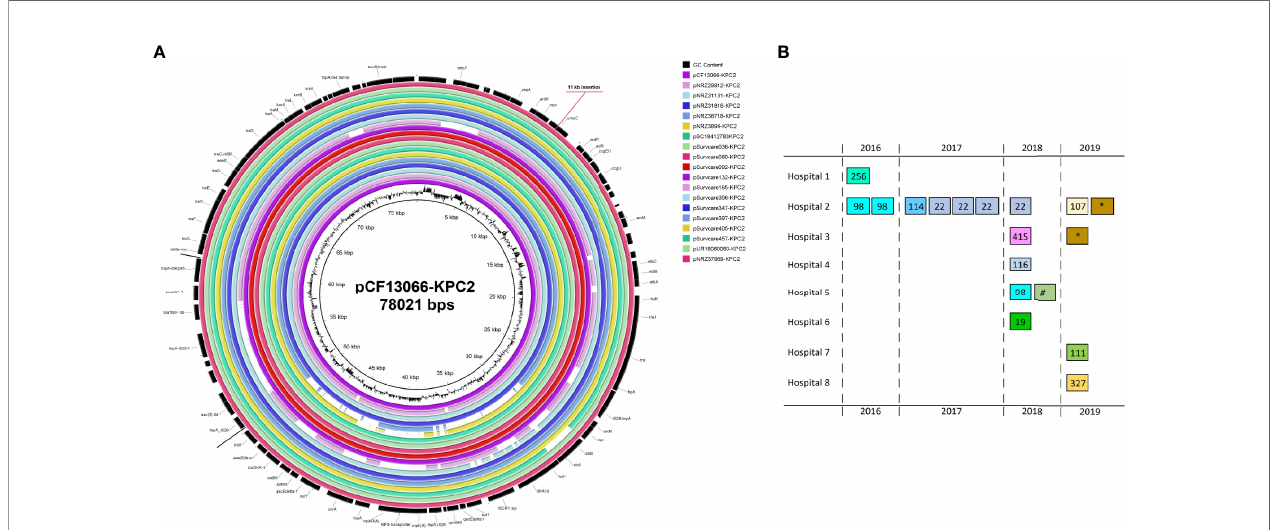
FIGURE 2 | Genetic map of the completed genomes of the bla KPC-2 -encoding IncN[pMLST15] (A) and the distribution of the IncN pMLST15 plasmids according to the time from 2016 to 2019 and hospitals as well as the genome types and species (B) . The plasmid pCF37969-KPC2 was almost identical to the early identi fi ed pCF13066-KPC2, which has been isolated from a multi-species carbapenem-resistant outbreak in 2014 in Hesse (separate study), and differed by a ~11 kb insertion. Each box in (B) indicates one isolate. The numbers in the boxes indicate the MLST-types of the C. freundii isolates as well as the symbol (*) for the species C . koseri and the symbol ( # ) for C. portucalensis .